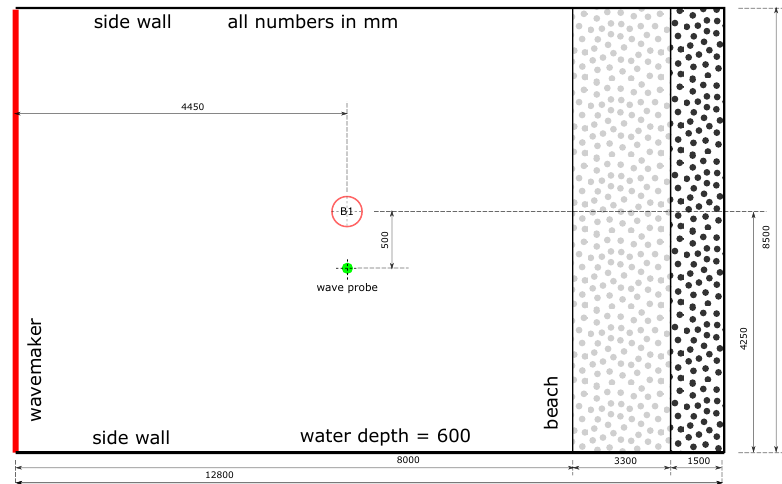
Figure 3. Basin layout with location of the model (B1) and the wave probe. (Note that the drawing dimensions are